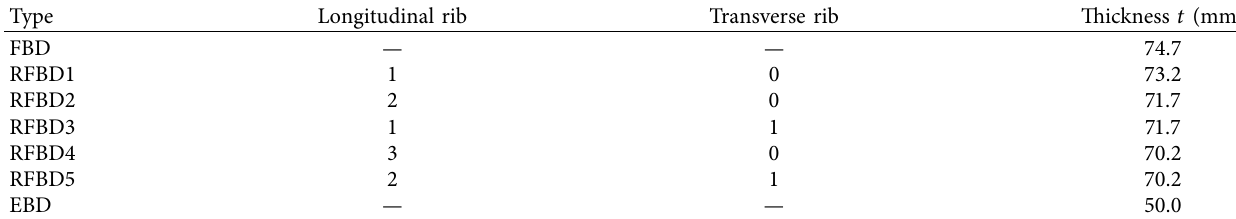
Table 3: Parameters of different blast-resistant doors.